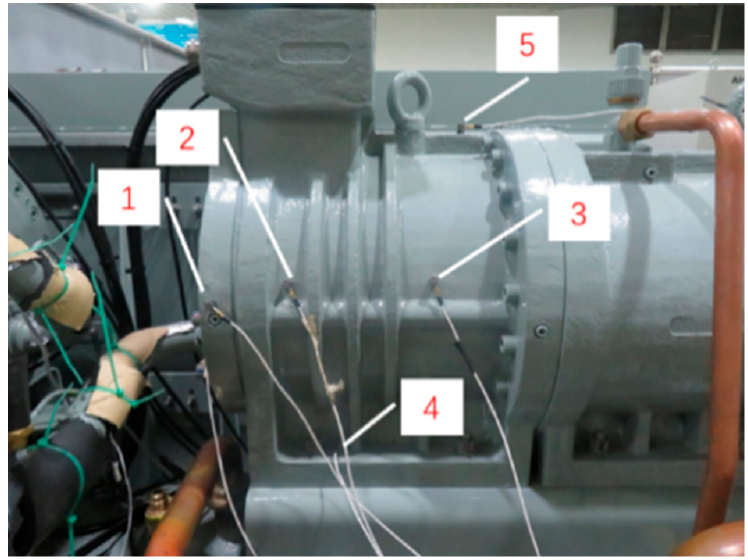
Figure 7. Experimental motor (The numbers in figure are the testing point of vibration acceleration).